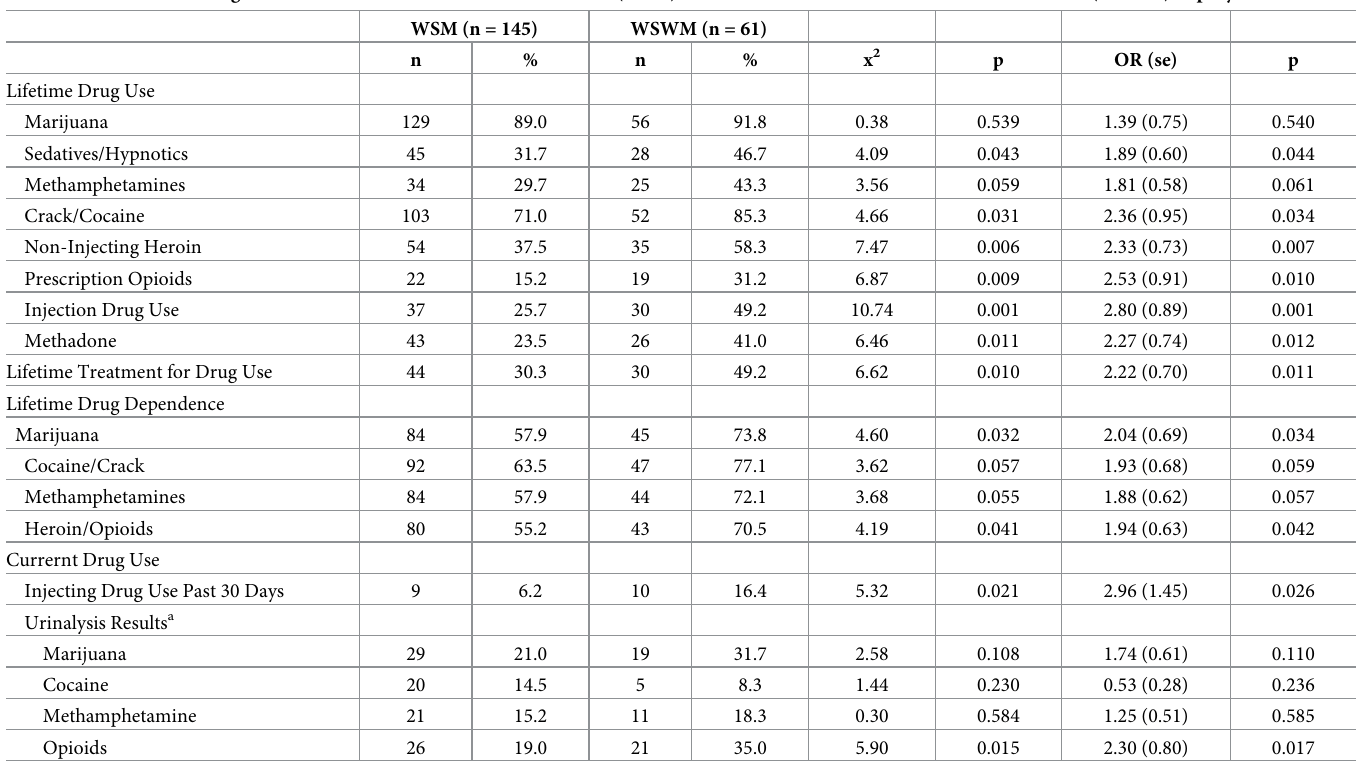
Table 3. Differences in drug use between Women who have Sex with Men (WSM) and Women who have Sex with Women and Men (WSWM) in proyecto SALTO.